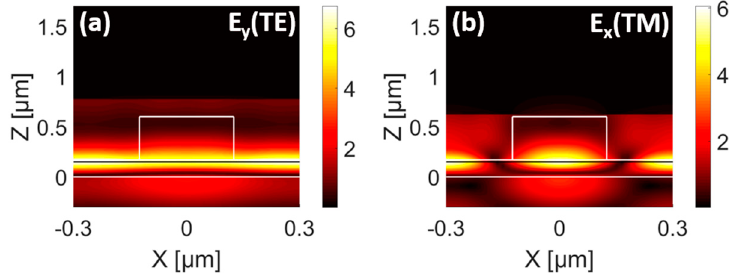
Figure 3. Field profiles ( a ) amplitude of Ey component and ( b ) amplitude of Ex component at 0.9 µm for the device parameters of Figure 2. The white lines show the device structure where the monolayer graphene is positioned at z = 0.15 µm (marked by the black line).